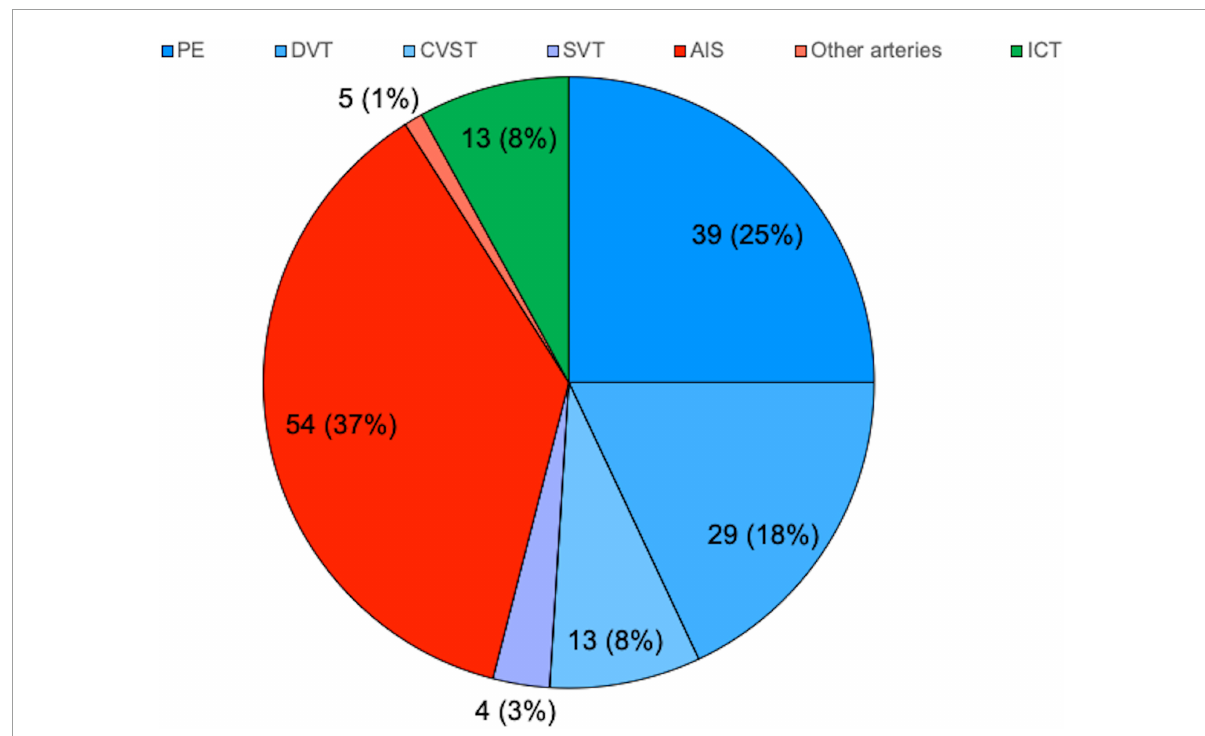
FIGURE2 Distribution of thrombotic events by localization. N (%), expressed on the total of 157. AIS, arterial ischemic stroke; CVST, central venous sinus thrombosis; DVT, deep venous thrombosis; ICT, intracardiac thrombosis; PE, pulmonary embolism; SVT, splanchnic venous thrombosis.